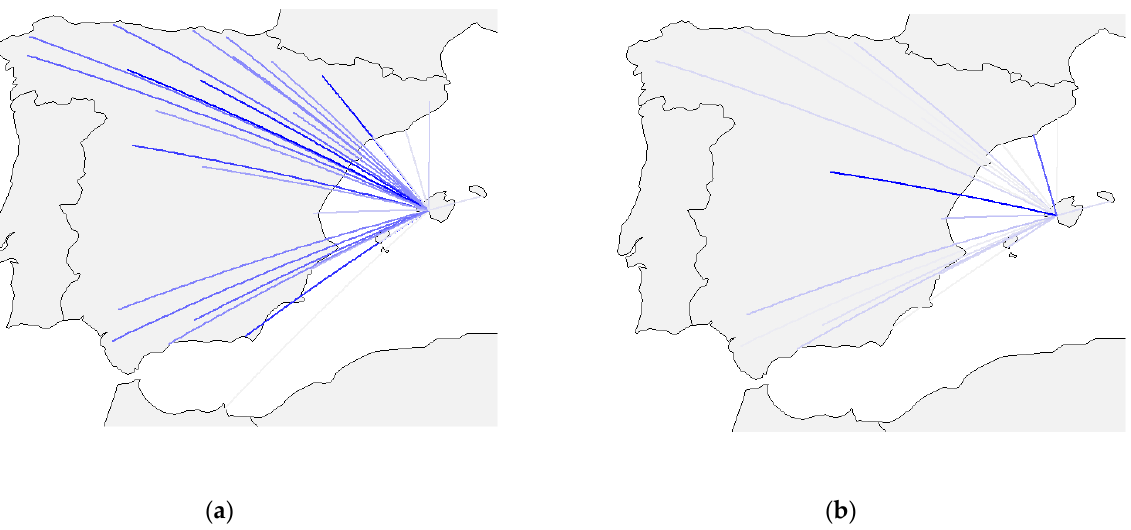
Figure 11. Carbon dioxide emissions from main domestic corridors operating in PMI airport, where a rough sketch means more emissions than the thinner one as follows: ( a ) Partial emission per passenger and route (arithmetic average: 76.18, standard deviation: 30.21); ( b ) Total emission of routes concerned. Source: own elaboration from the data provided by [19,20].